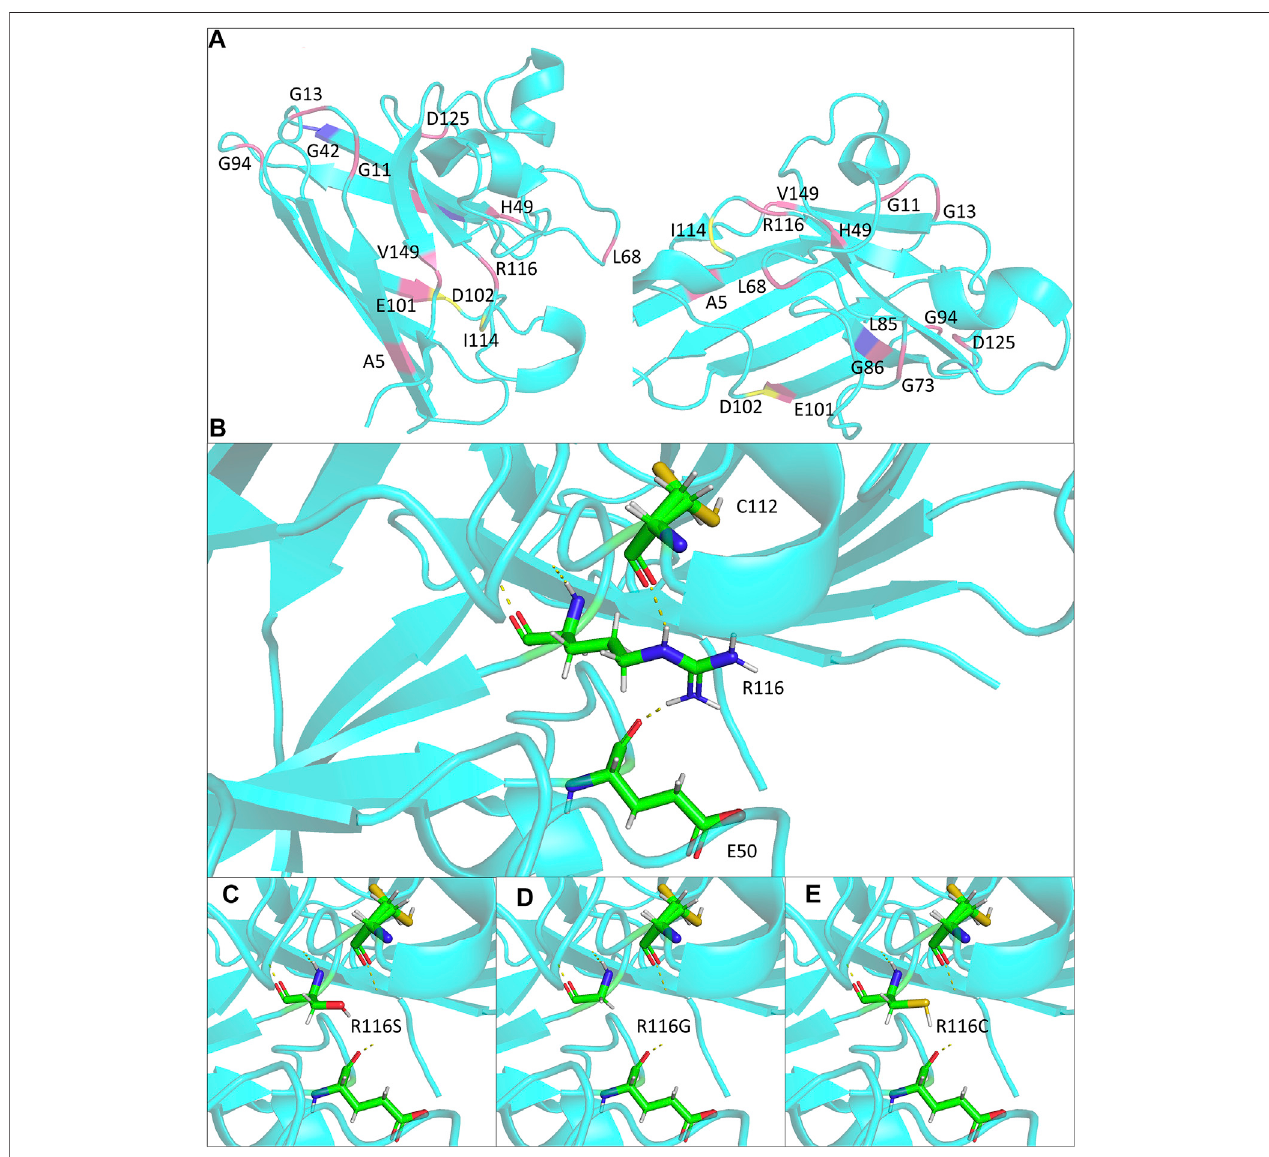
FIGURE 2 | Structural modeling of the ALS-associated SOD1 R116 mutants in the study. (A) Monomer views of the SOD1 homodimer (PDB: 2c9v). Mutations discussed in Table 1 are highlighted and annotated. (B – E) Close lookup views of the hydrogen bonds (yellow dash line) for R116 and mutants R116S, R116G, and R116C,